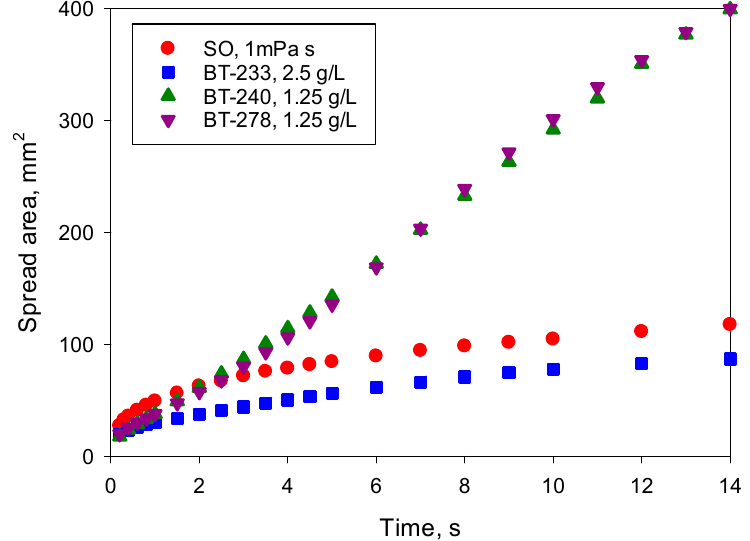
Figure 3. Comparison of spreading kinetics on PVDF of silicone oil with that of non-superspreading (BT-233) and superspreading (BT-240 and BT-278) surfactant solutions in water. The data for surfactant solutions are presented for concentrations providing the maximum spreading rate.